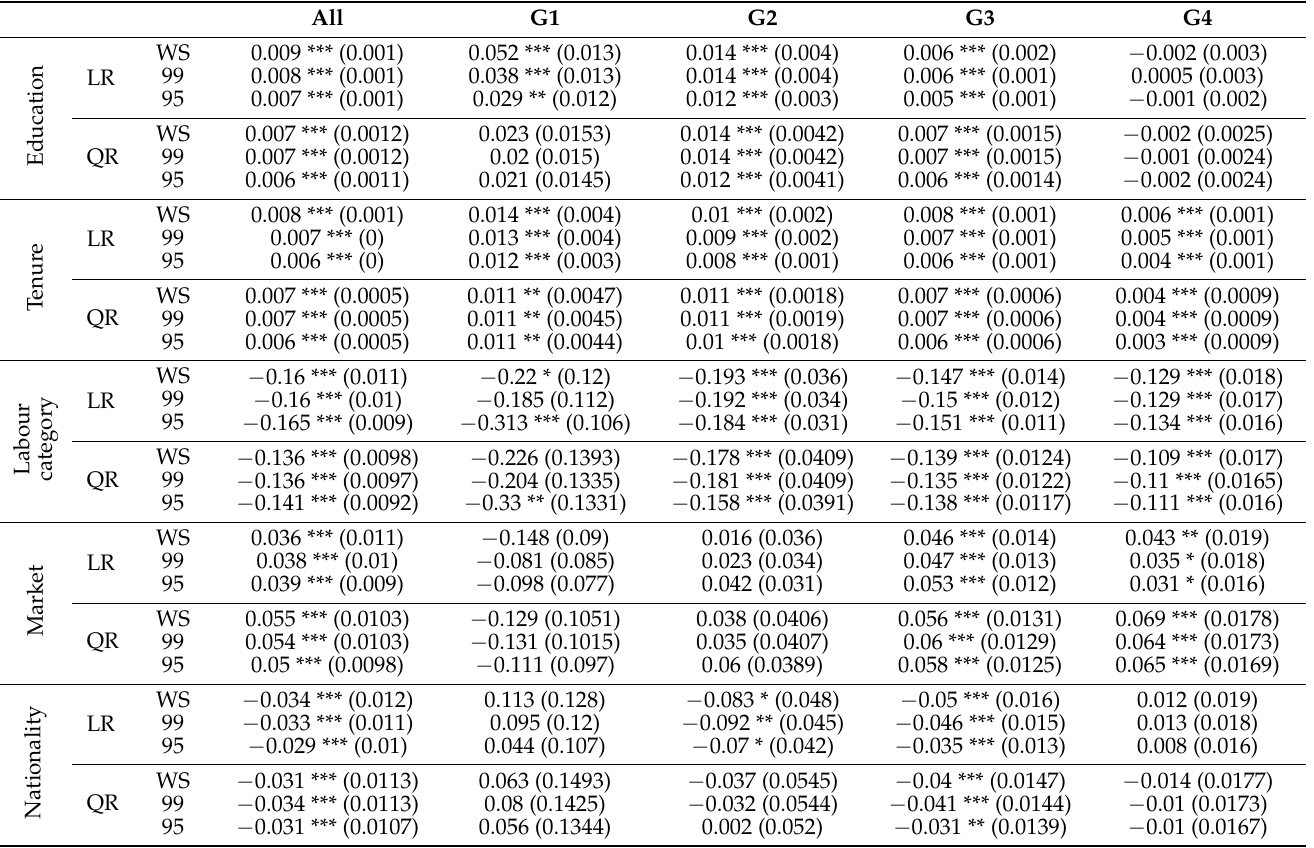
Table 3. Results of the estimations of the